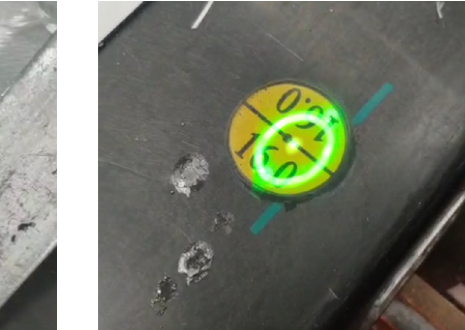
16 of 19 Figure 12. The initial state of projection imaging.